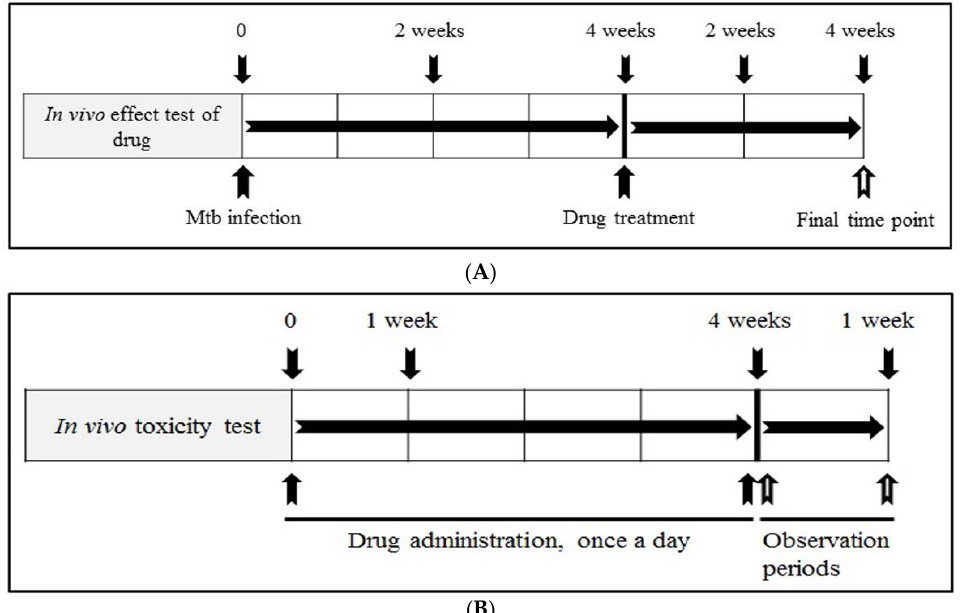
Figure 1. Experimental design for in vivo tests of artesunate and artemisinin. ( A ) The evaluation of in vivo effects; the rats were divided into a normal group ( n = 5), positive control group ( n = 5/isoniazid group) and experimental groups (artesunate and artemisinin groups, n = 5/each group). The rats were orally administered with a single dose of 5 mg/kg of isoniazid, and 3.5 mg/kg of artemisinin and artesunate, once a day for four weeks, after four weeks of Mtb infection, respectively; ( B )